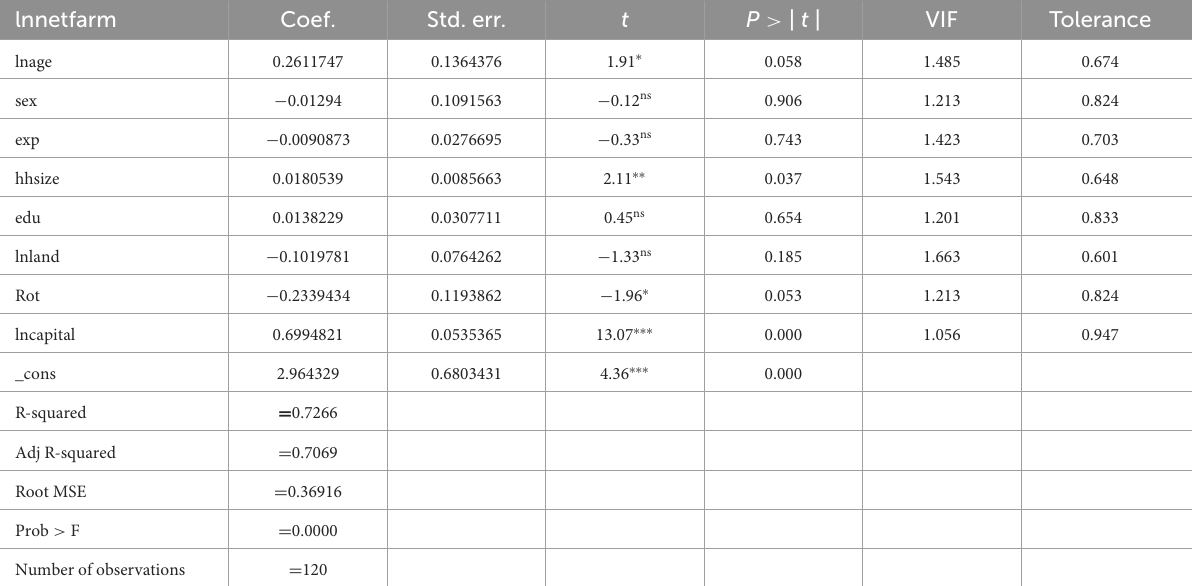
TABLE 5 Regression results of factors influencing sesame output. lnnetfarm